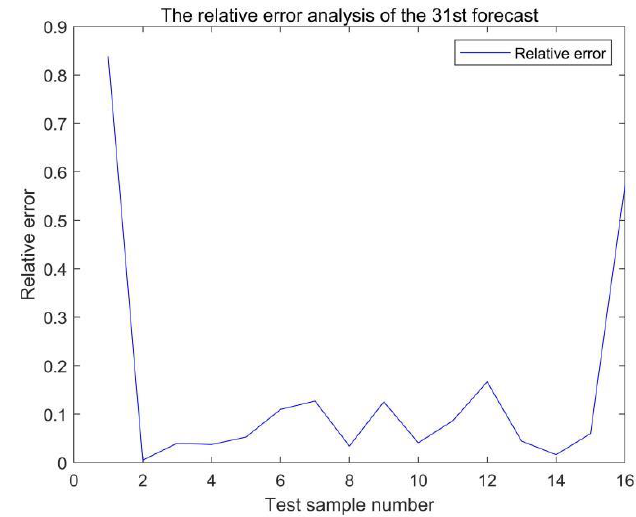
Figure 26. The relative error analysis of the prediction set.